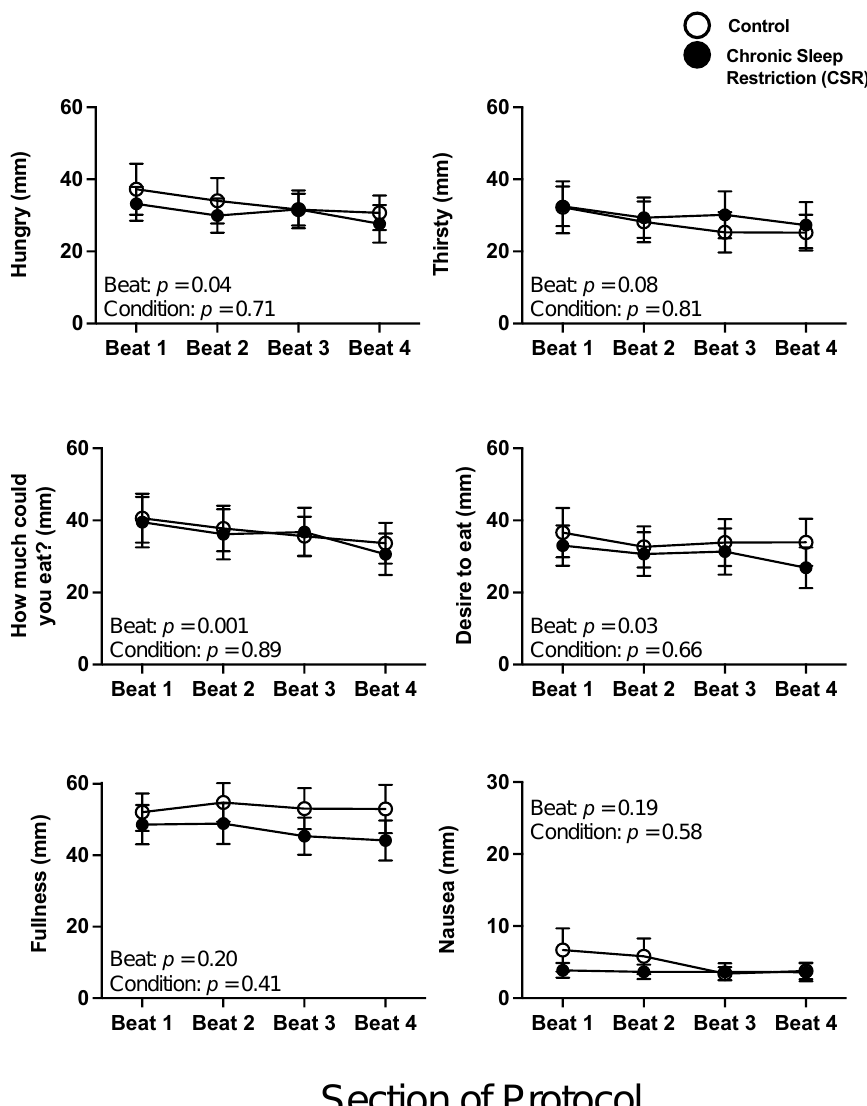
Figure 1. Acute and chronic impact of circadian disruption and sleep restriction on subjective hunger and appetite. Data from the Control ( n = 8, 1:2 sleep:wake ratio) participants are denoted by open circles and those from the Chronic Sleep Restriction (CSR, n = 9, 1:3.3 sleep:wake ratio) participants are denoted by closed circles. Higher scores indicate higher subjective feelings of each aspect of hunger and appetite; the possible range was 0 – 100. Beat cycles (i.e., time to complete a cycle of circadian and sleep:wake schedule combinations, which was ~6 protocol days in this forced desynchrony design) of the protocol are shown on the x -axis. Error bars represent SEM. Note, the y -axis scale of Nausea is one-half the range of the others. p values are derived from linear mixed models with beat cycle, condition, and their interactions as fixed effects and participant as a random factor.